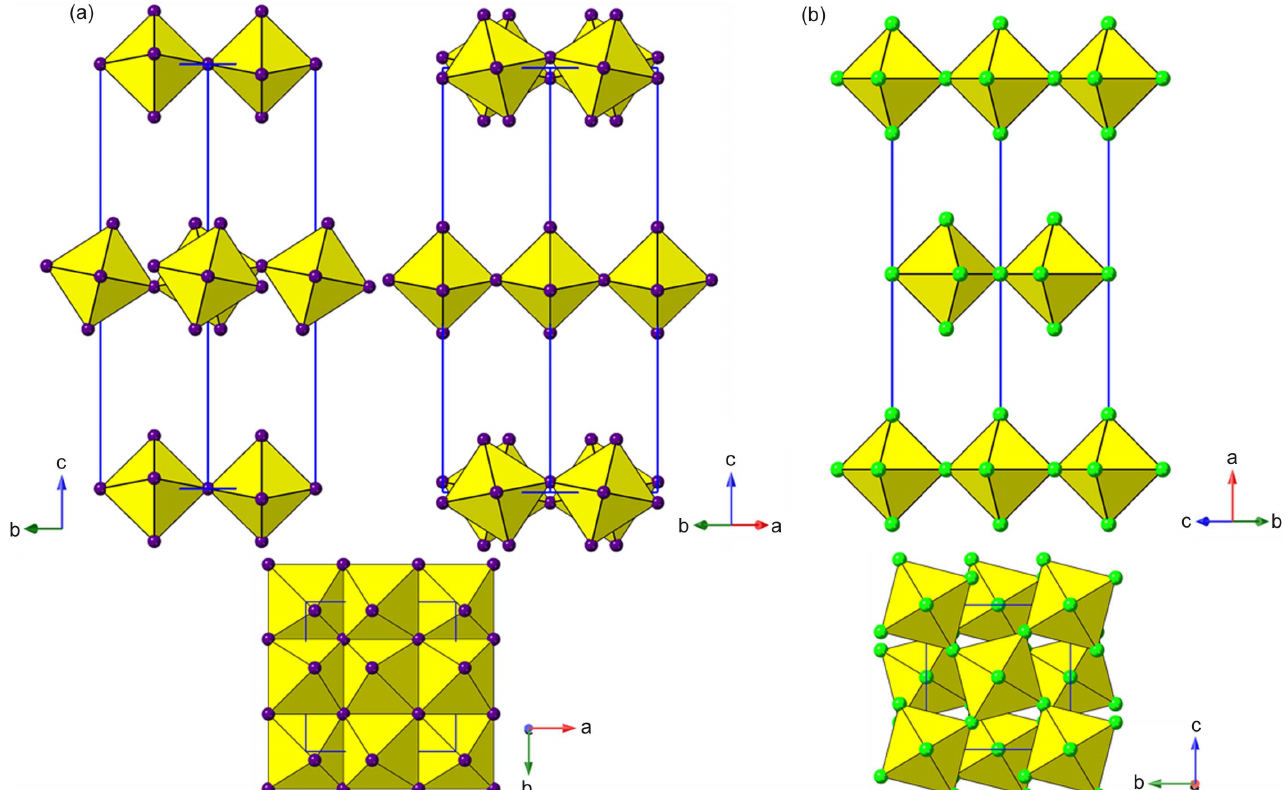
Figure 5 Octahedral frameworks of two structures with a single tilt mode ( a ) X 3+ (a, a) tilt mode (1863837) and ( b ) X 2+ (0, a) rotation mode (2016195). Note the out-of-phase tilting around the ab plane and alternating direction of tilts in ( a ) and the absence of layer-plane tilting but presence of rotations of the same degree around the c axis in ( b